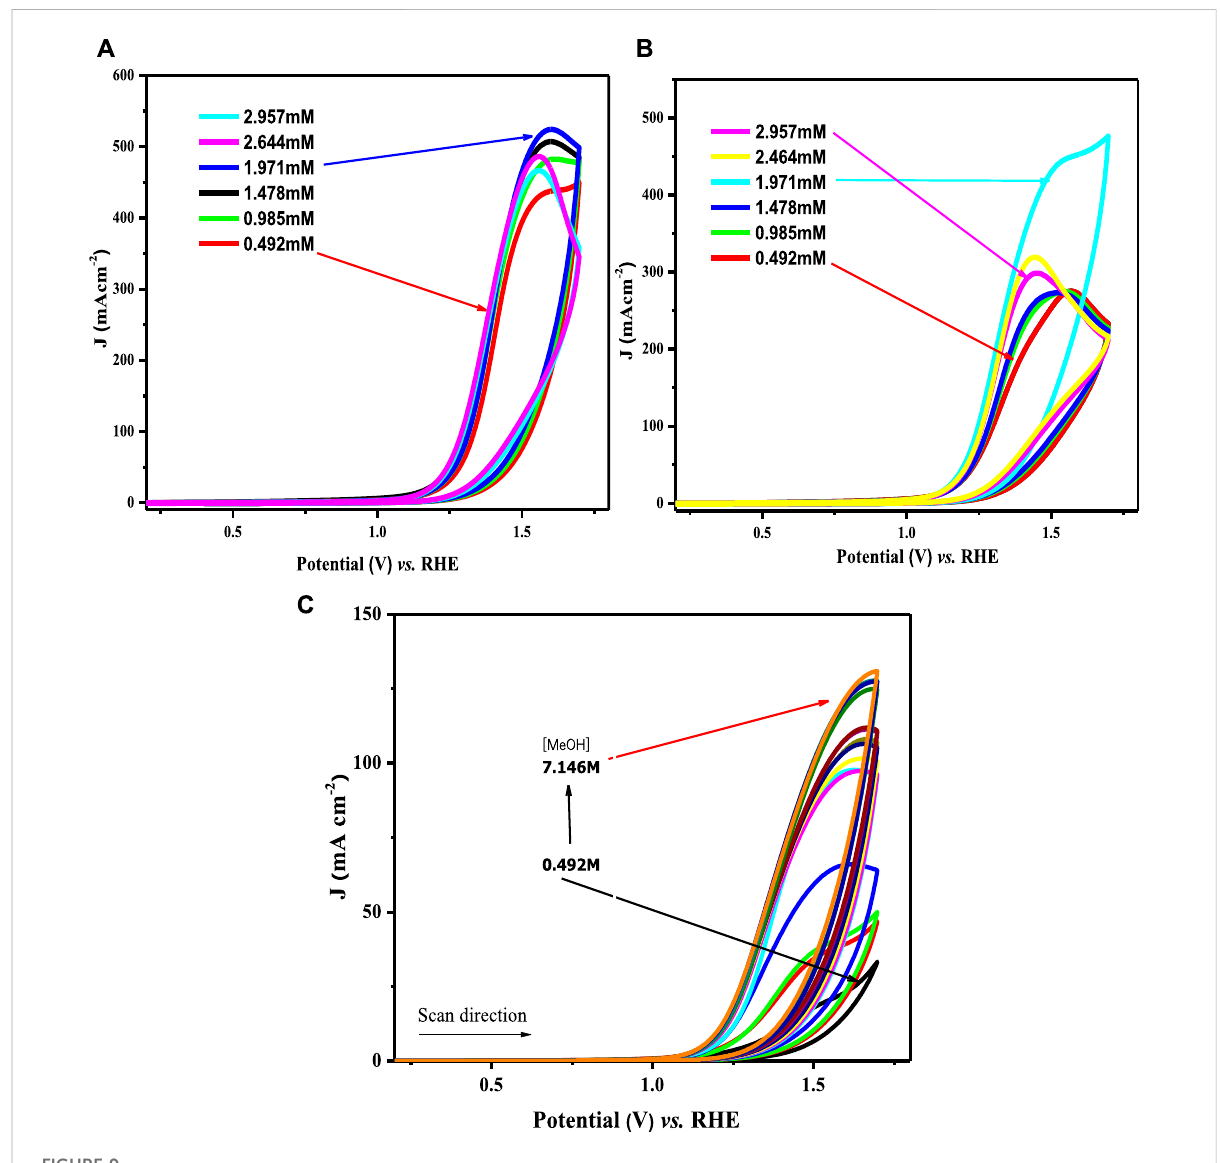
FIGURE 9 Cyclic voltammograms for water oxidation in different methanol concentrations on (A) LCNiO-1/GC, (B) LCNiO-5/GC, and (C) LCNiO-9/GC electrode.